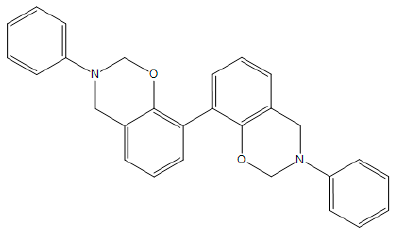
Figure 3. Structure of 22P-a.